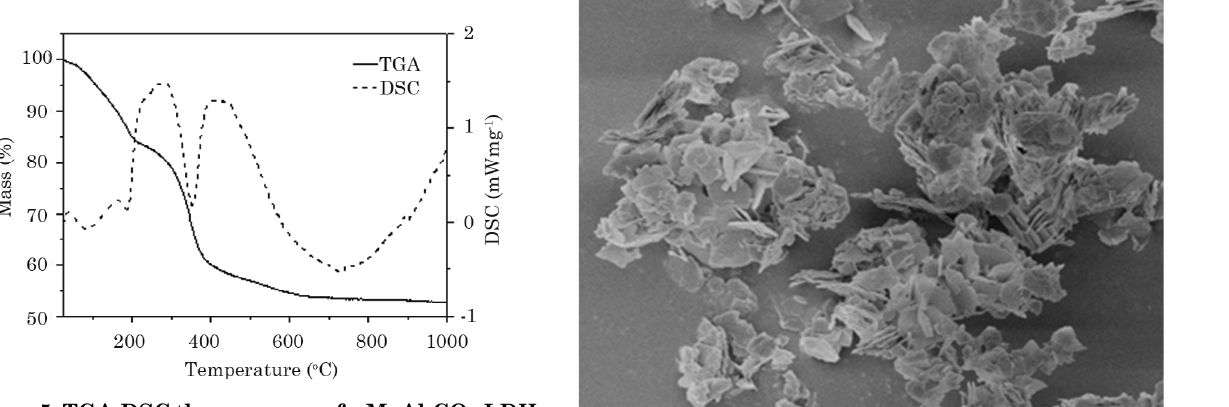
Figure 5. TGA-DSC thermogram of a MgAl-CO 3 -LDH. Source: Tronto (non-published